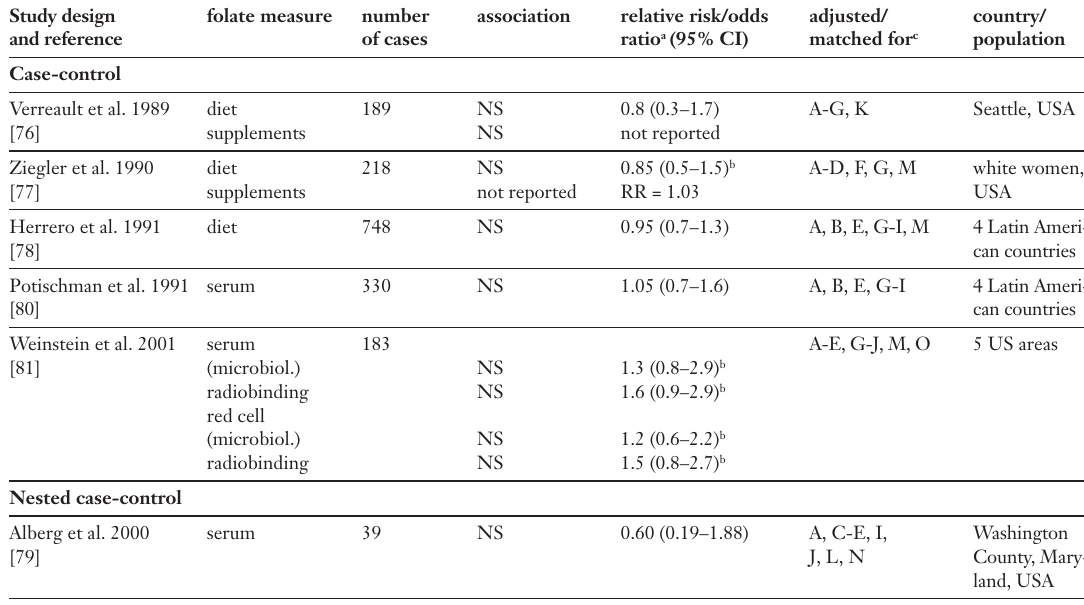
Folate and the risk of colorectal, breast and cervix cancer: the epidemiological evidence